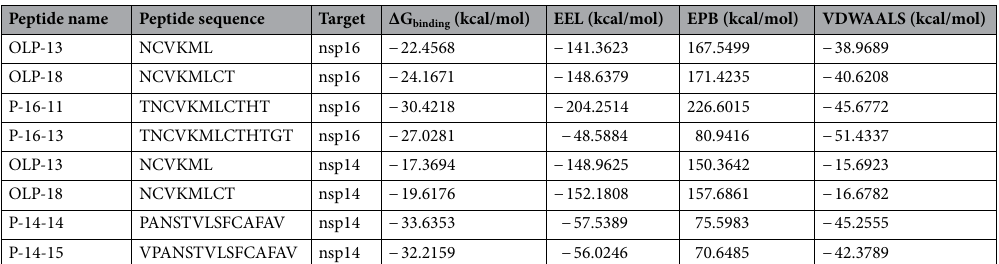
Table 3. The binding free energies of the designed peptides calculated by MM-PBSA